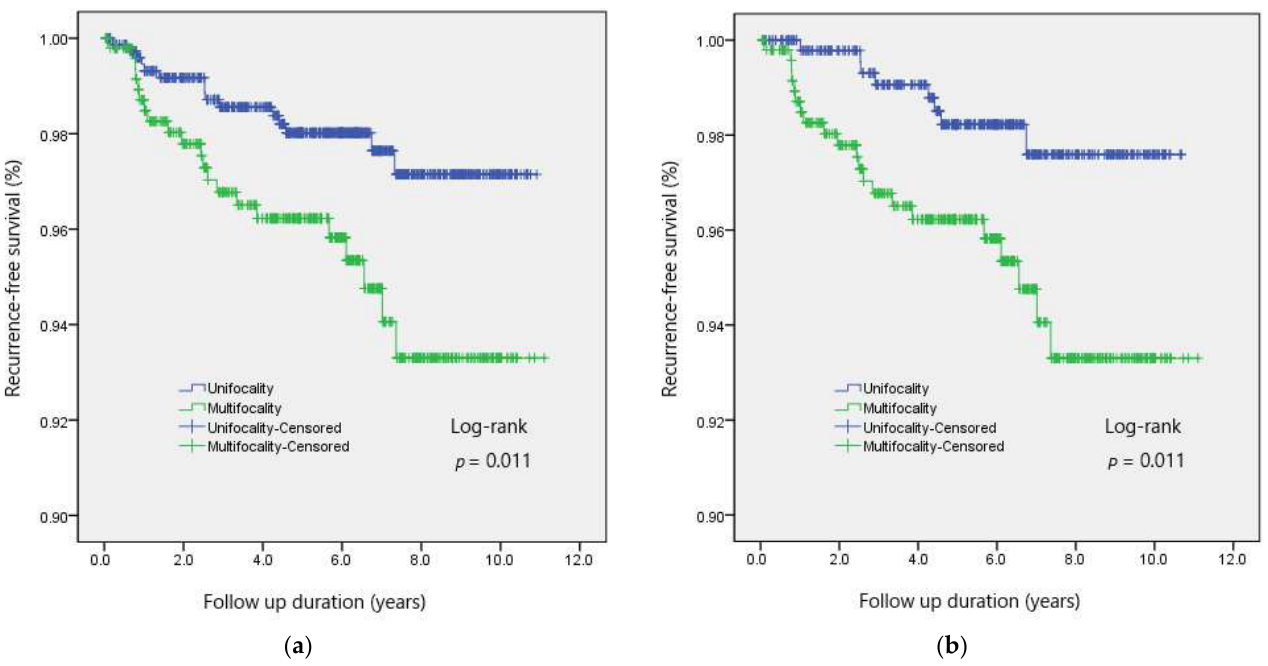
Figure 1. Recurrence-free survival according to the multifocality in patients with PTC, ( a ) before and ( b ) after propensity score matching. Table 2. Comparison of clinicopathological characteristics between patients with multifocal PTCs and those with unifocal tumor after propensity score